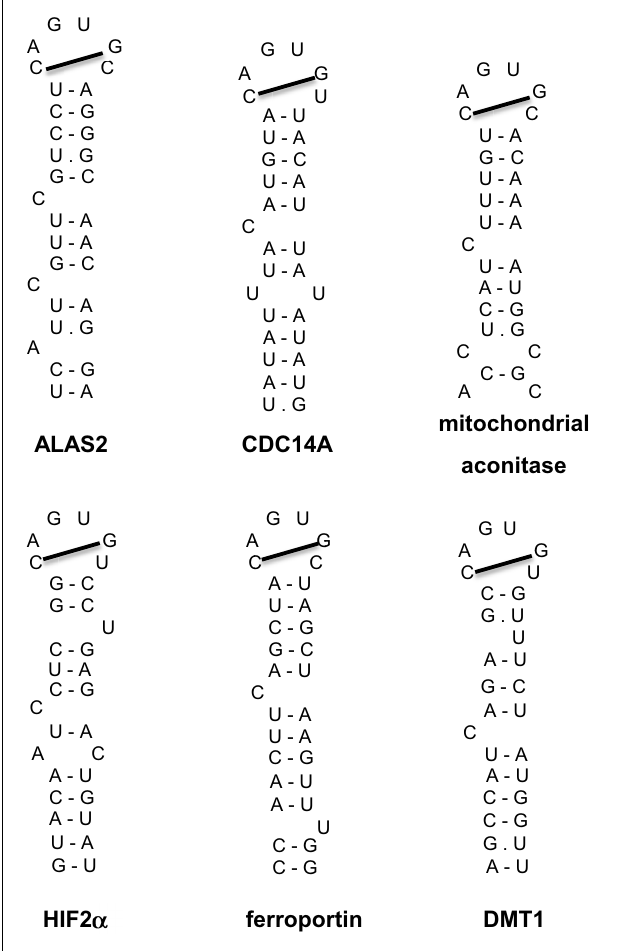
to defective assembly of its 4Fe-4S cluster (Wingert et al.,